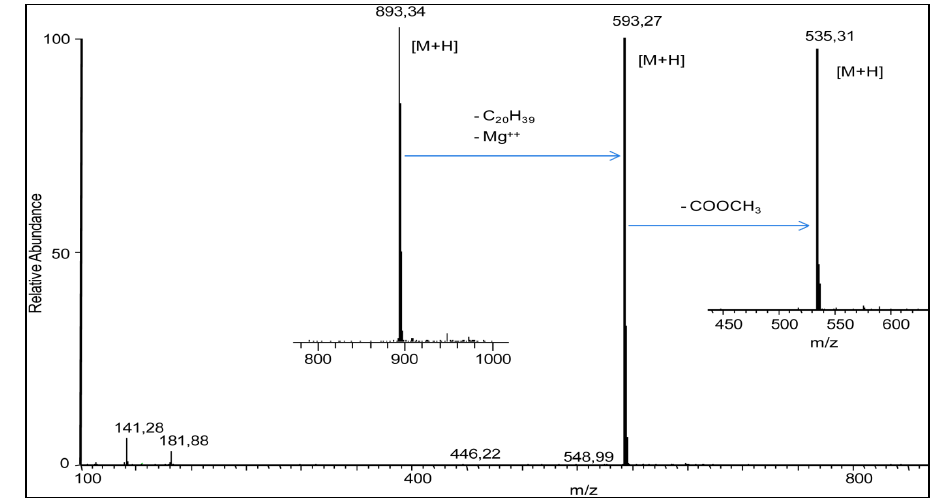
Fig. 3. Positive ion APCI mass spectrum of Chl and early metabolites from frass extracts of A. urticae monitored by LC-UV-DAD-MS. The difference between [M+H] peak of Chl a m/z 893.34 (small, left) to Phe a m/z 593.27 (big) as well as the decarboxylated peak of Pph a m/z 535.31(small, right) demonstrates the successive cleavage of Phe a